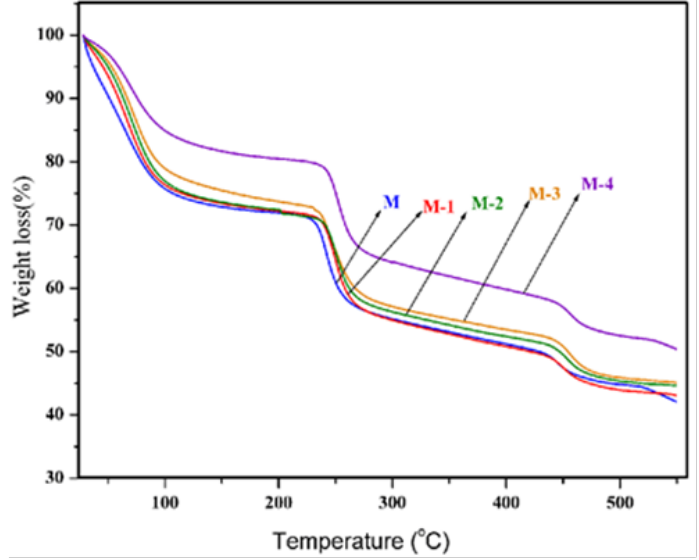
Figure 3. Thermogravimetric analysis of crosslinked sodium alginate and related nanocomposite membranes. M: 0%, M-1: 10%, M-2: 20%, M-3: 30%, and M-4 40% titanium dioxide (all % w / w ).